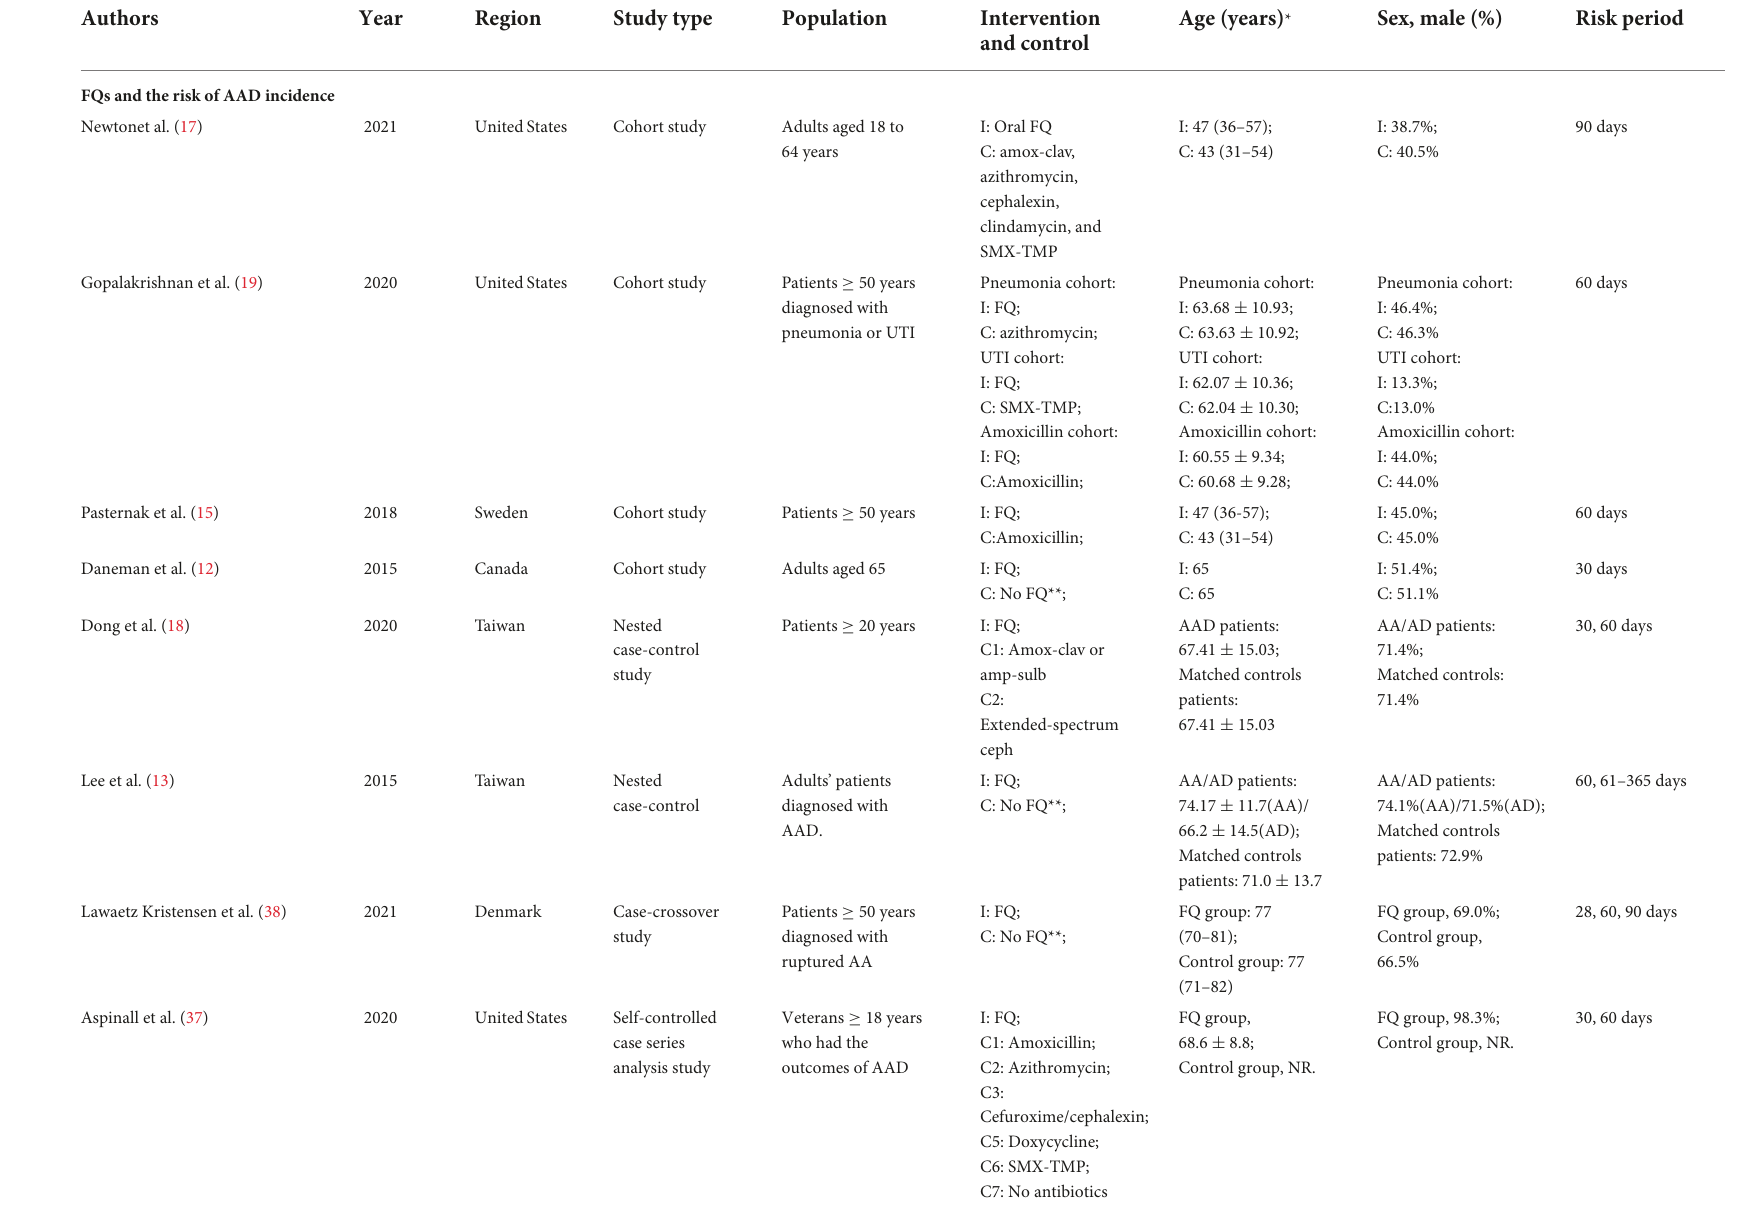
TABLE 1 Characteristics of included